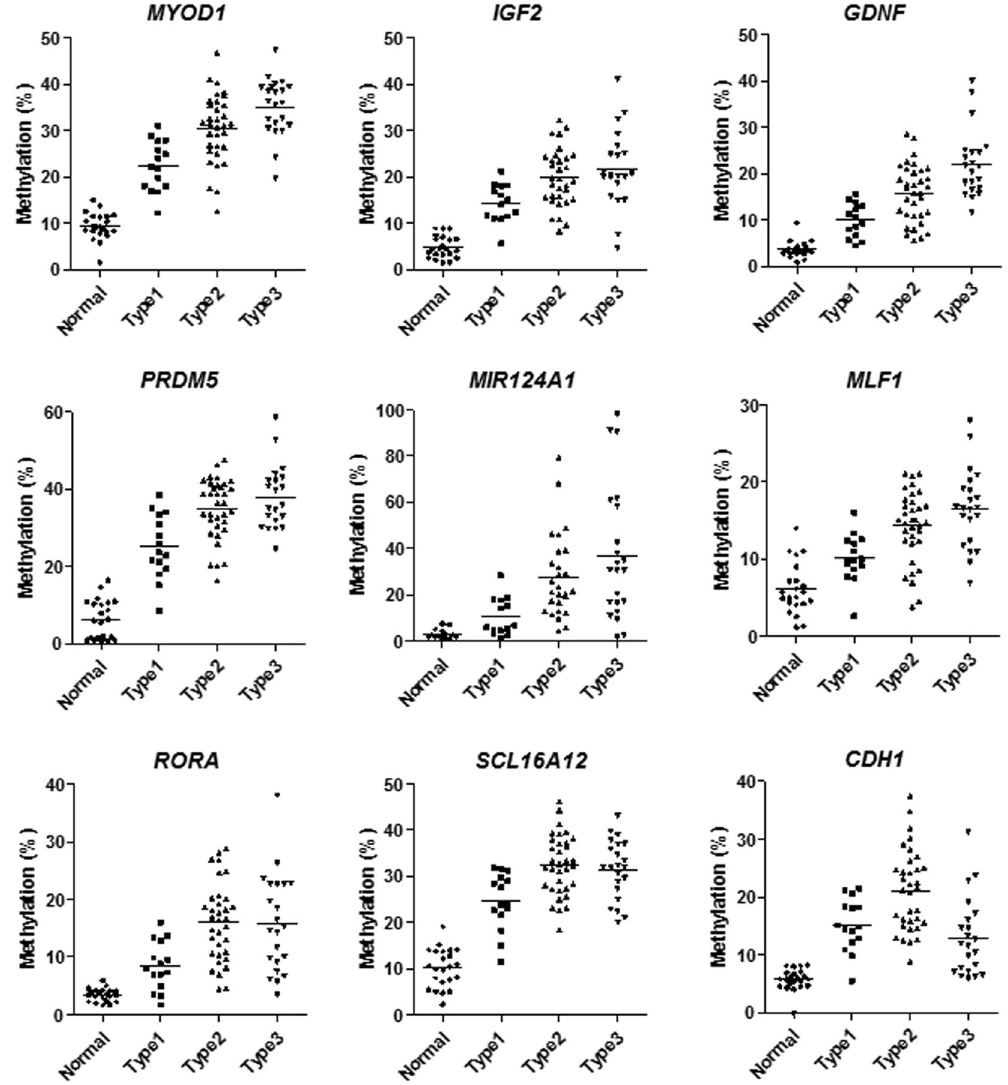
Figure 3. Methylation status of individual genes in relation to the NBI mucosal patterns (all P values < 0.0001). Statistical analysis was performed using one-way ANOVA.